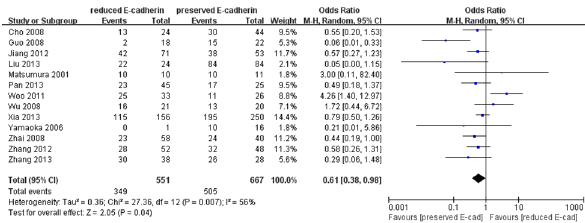
Figure 9. Forest plot displaying the results of the meta-analysis on liver